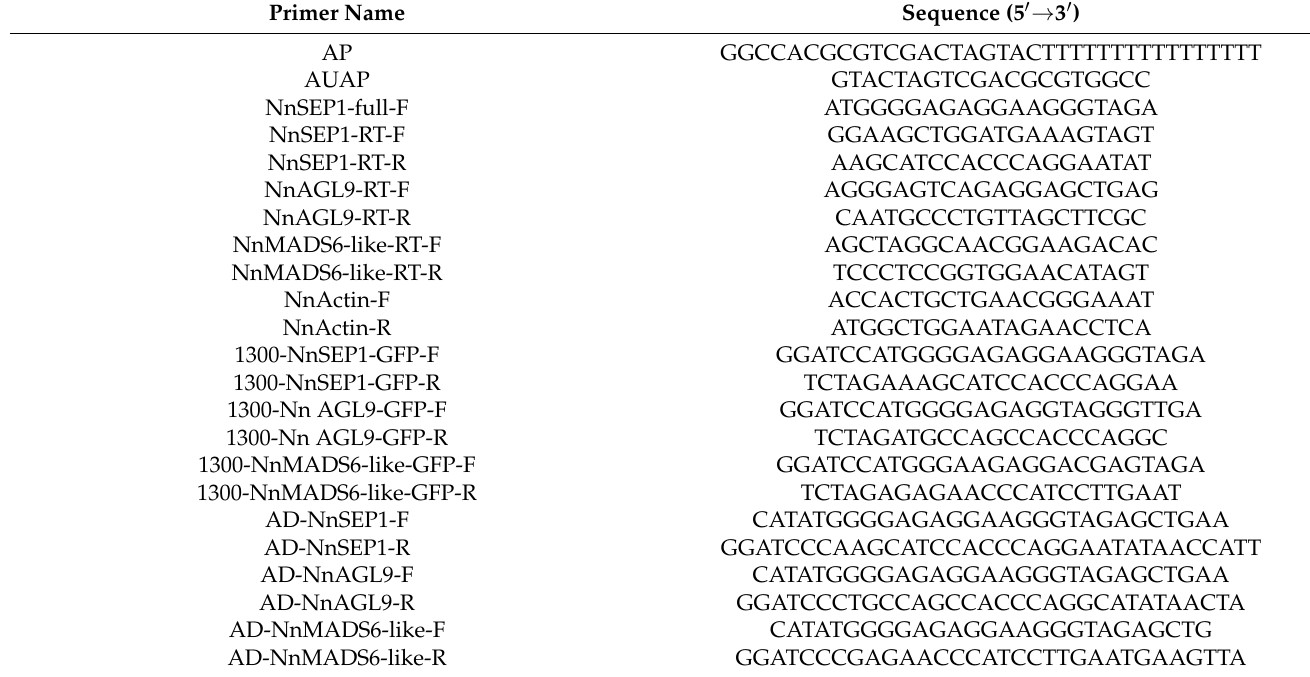
Table 1. The primers used in this